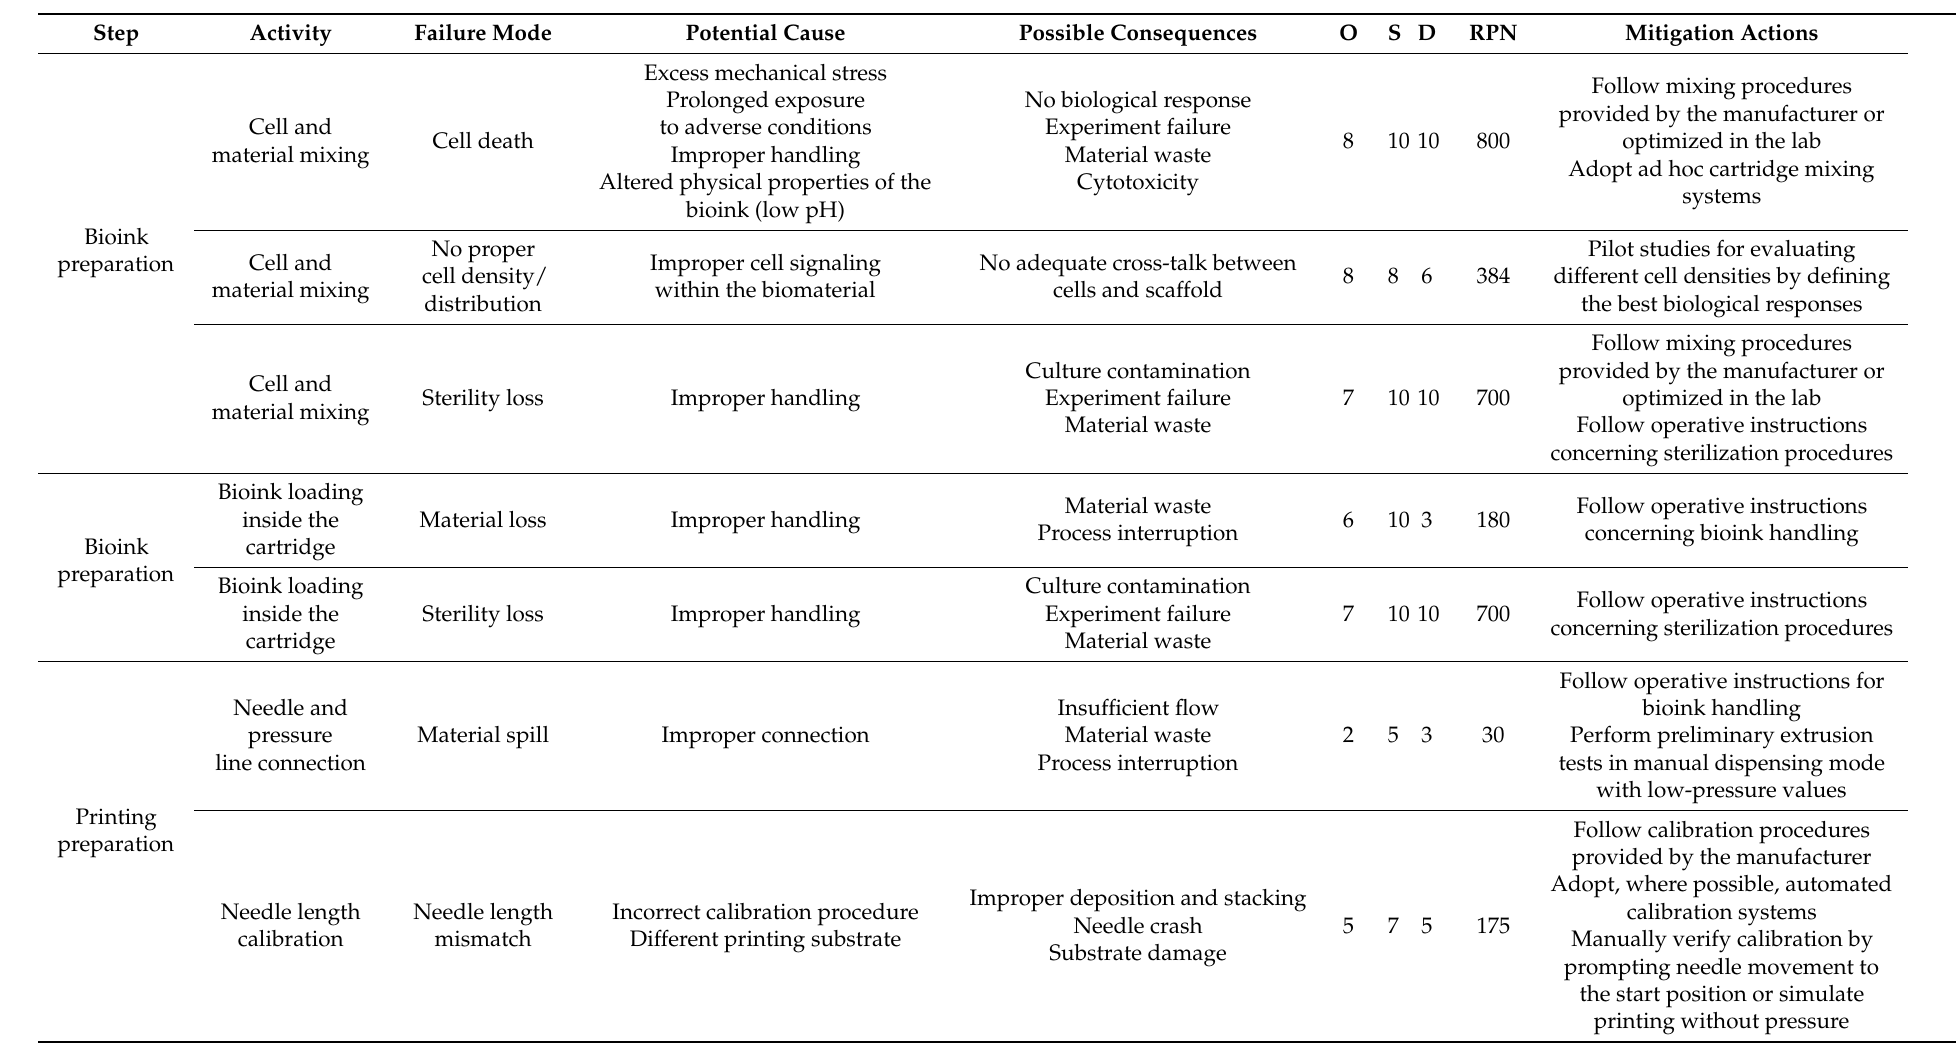
Table 6. FMEA/FMECA of Bioprinting